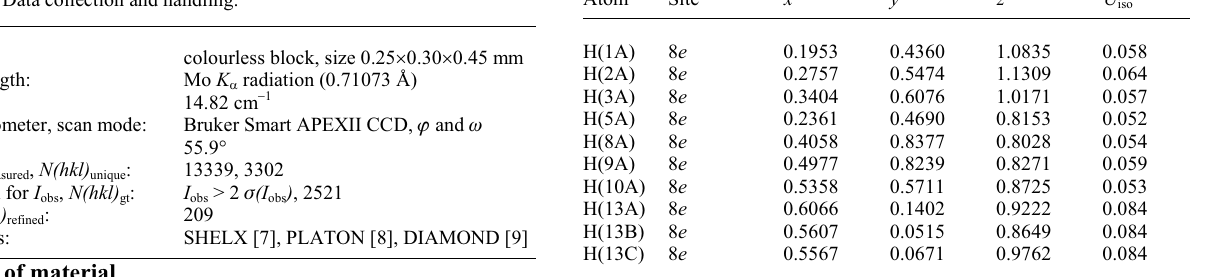
Table 1. Data collection and handling.